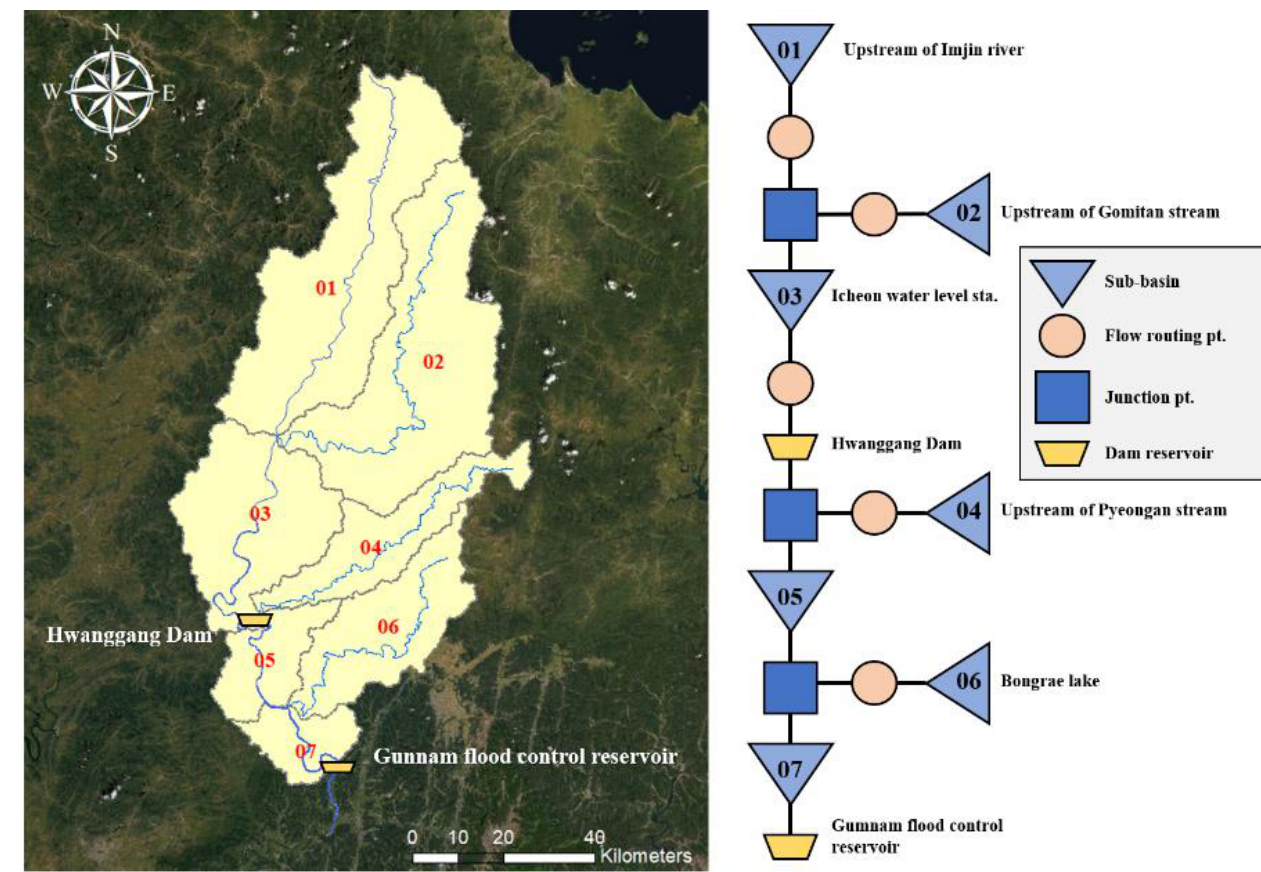
Figure 8. The sub-basin delineation and drainage network in the study area. Table 3. The sub-basin characteristics in the study area.